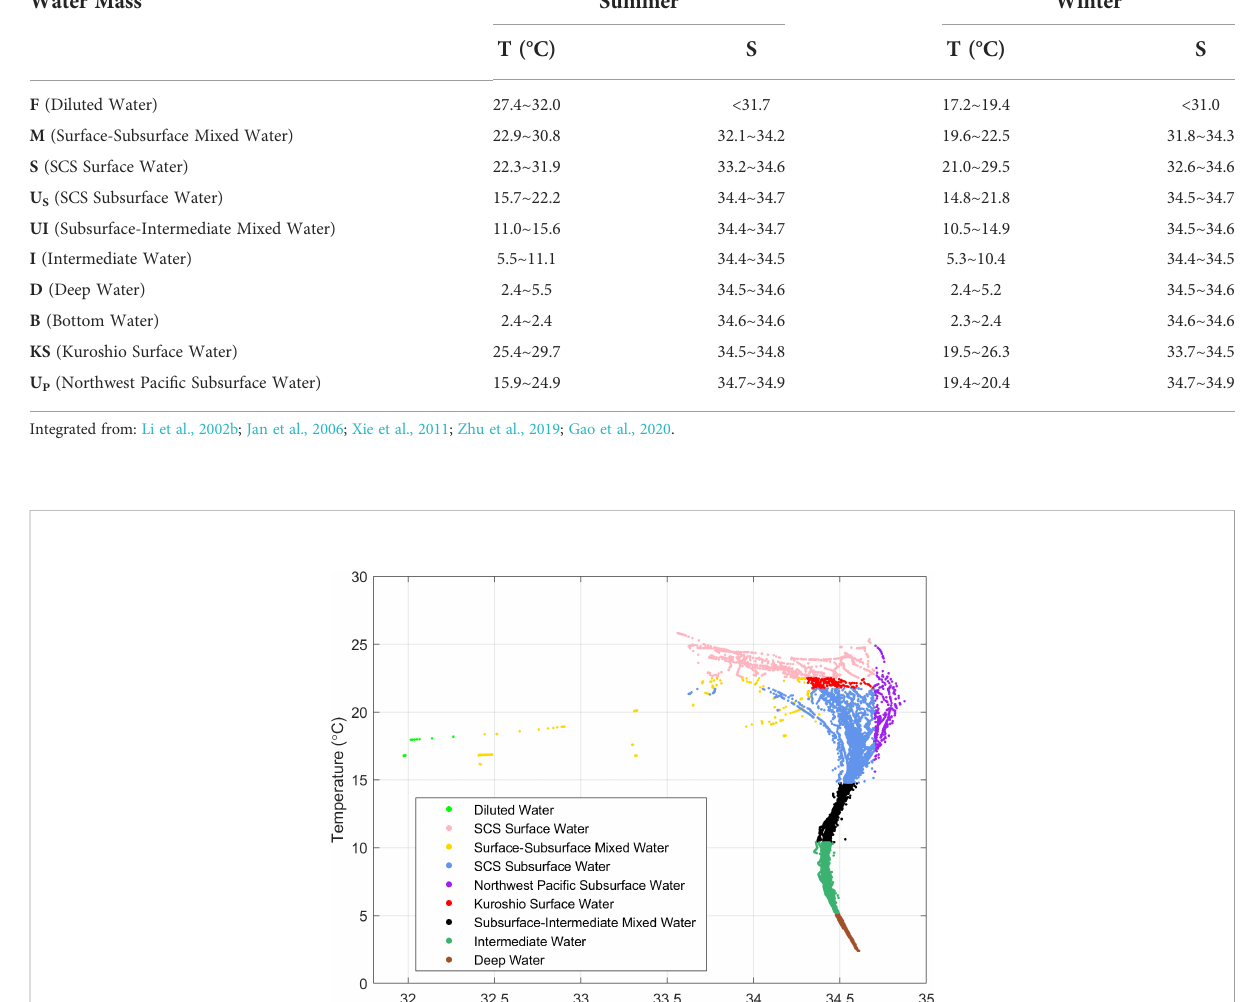
TABLE 4 The ranges of temperature and salinity of water masses of the SCS in summer and winter. Water Mass